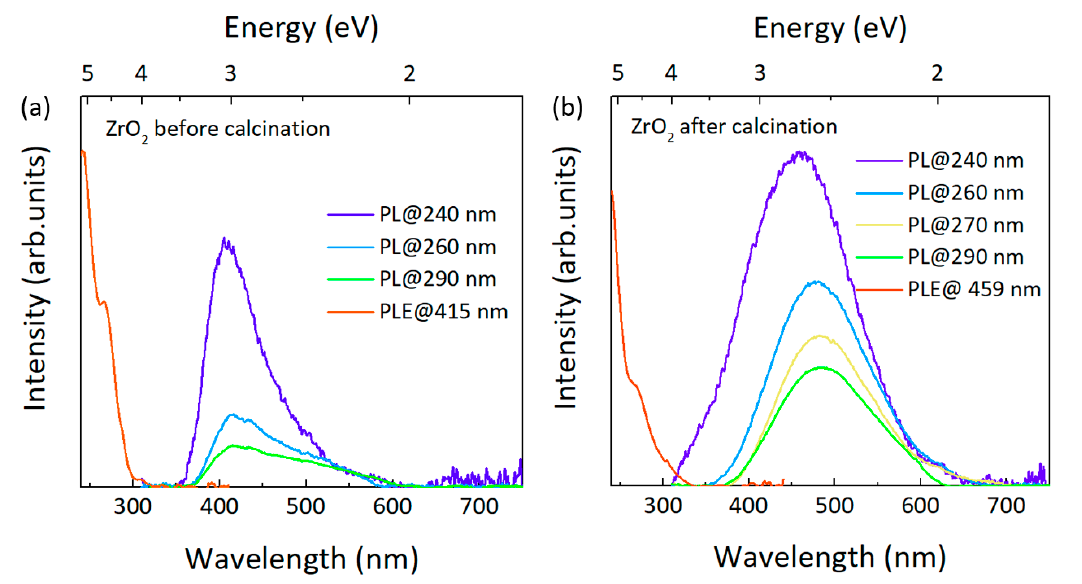
Figure 6. PLE/PL spectra acquired at RT on the ZrO 2 nanopowders ( a ) before and ( b ) after a calcination treatment at 800 °C for 15 min.